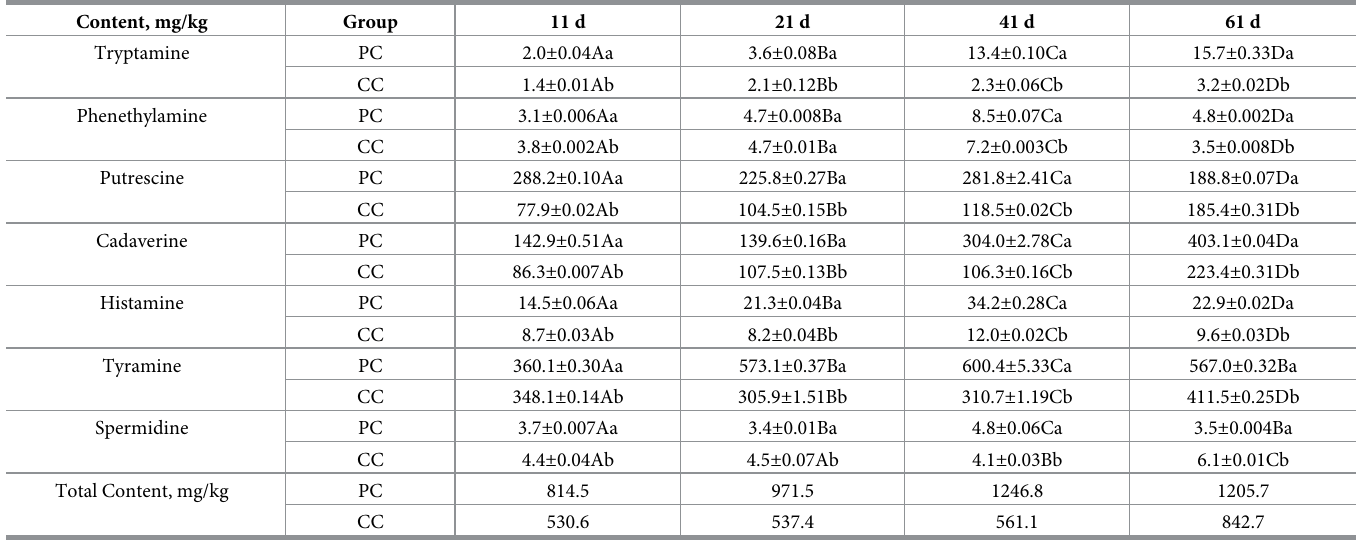
Table 7. Changes of biogenic amine